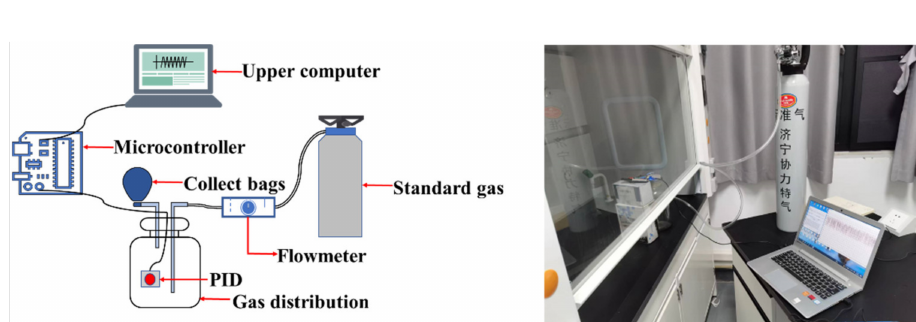
Figure 3. Experimental device of the PID module denoising for the online detection of